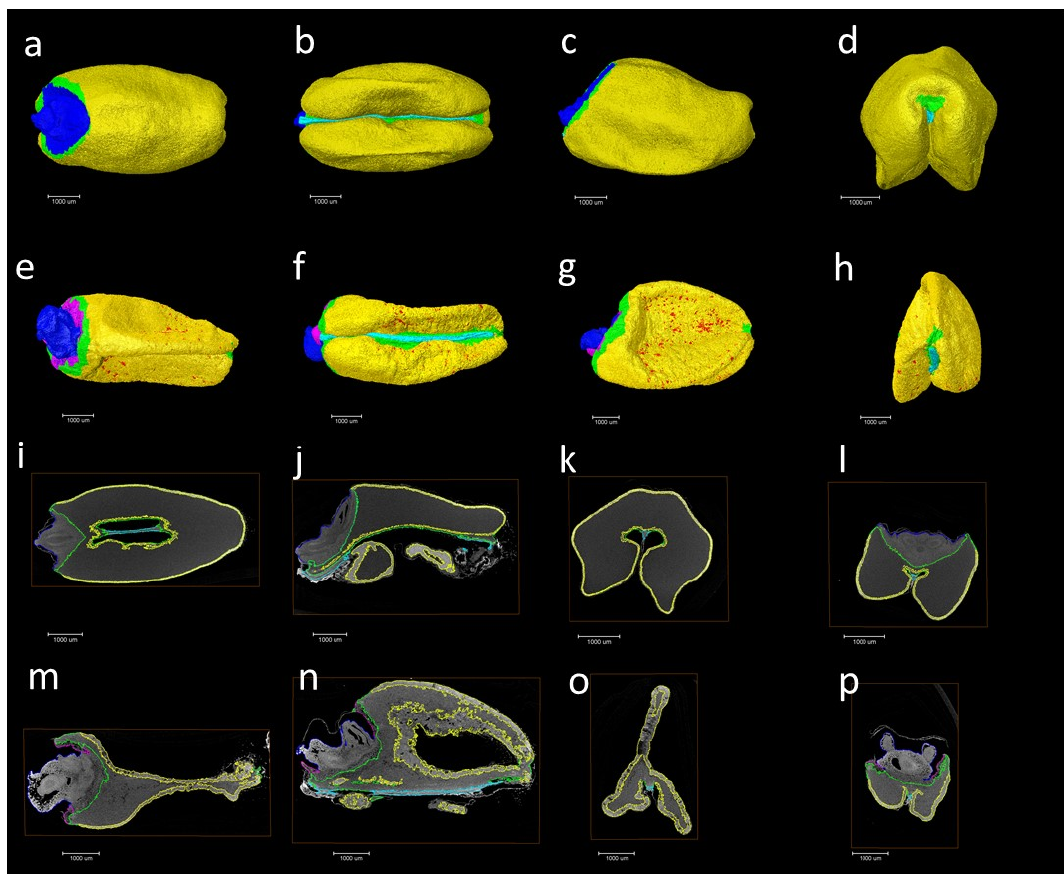
Figure 7. Pictures of seed surfaces ( a – h ) and examples of seed interiors ( i – p ) from X-ray microtomog- raphy analysis of mature wheat grains from field grown AsWRI1 -wheat. Pictures show the surface from dorsal side ( a , e ), ventral side ( b , f ), lateral side ( c , g ), and front ( d , h ) of seeds. Pictures ( i – p ) show examples of interior parts of seeds from similar orientations. Grain from control plant (line R3P8.12, null) in ( a – d , i – l ), grain from AsWRI1 -expressing line (R3P8.10, homozygous with 12 gene inserts) in ( e – h , m – p ). Color key: Yellow is aleurone, blue is germ and scutellum, green is endosperm, red is air pockets, cyan is the transfer bundle, and violet is the depleted region. Scale bars are 1000 μm.